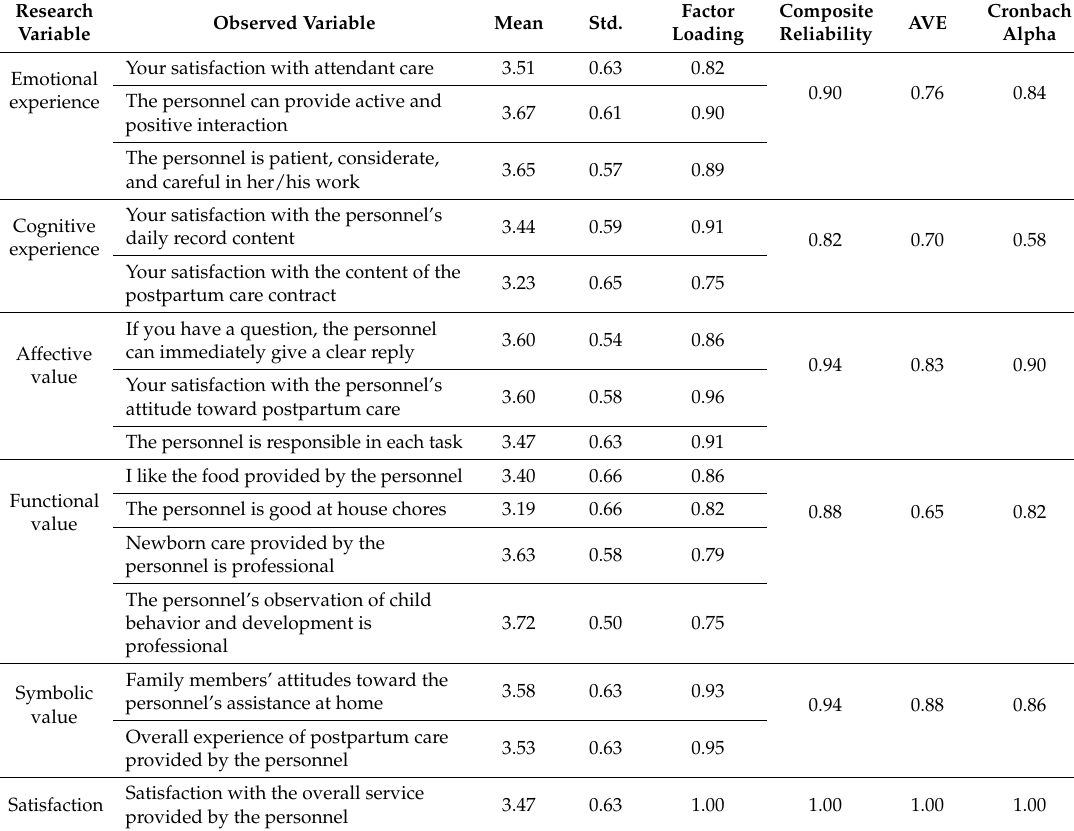
Table 2. Reliability and validity analysis of the postpartum service experience model.